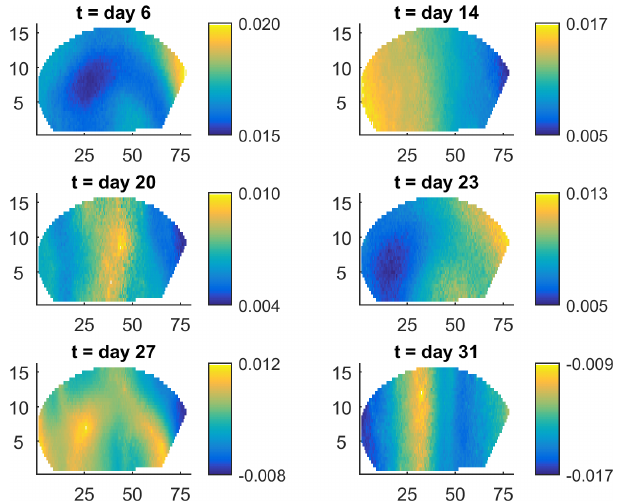
Figure 10. The difference in simulated water tables by MIKE SHE and MOBIDIC–MODFLOW ( h MOBIDIC-MODFLOW − h MIKESHE ; m) at different time steps.